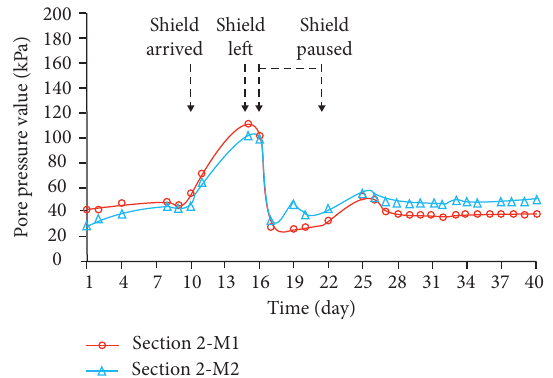
Figure 4: Curves of the pore pressure in Section 2.